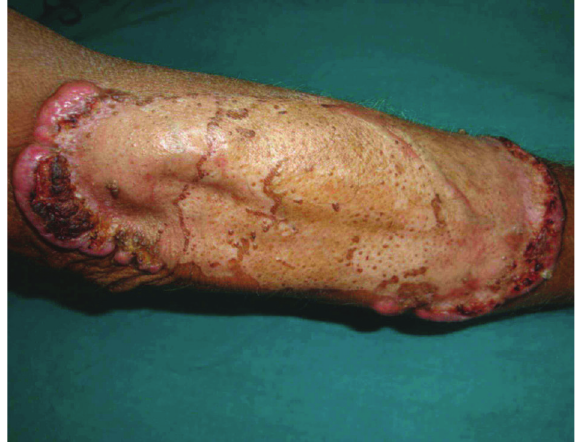
Figure 1: A plaque with nodular ulcerated margin and central scar- ing.